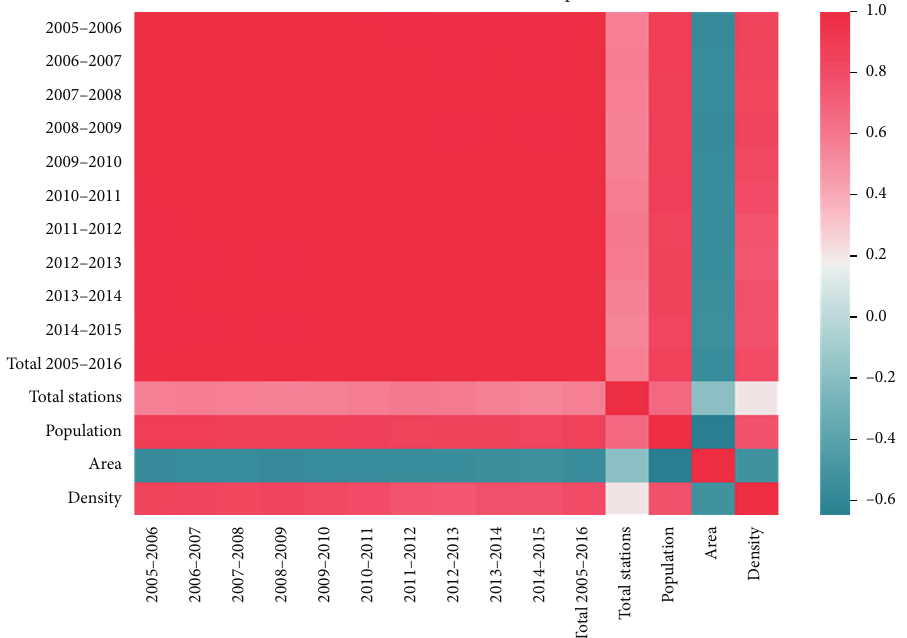
Figure 8: Correlation heatmap.